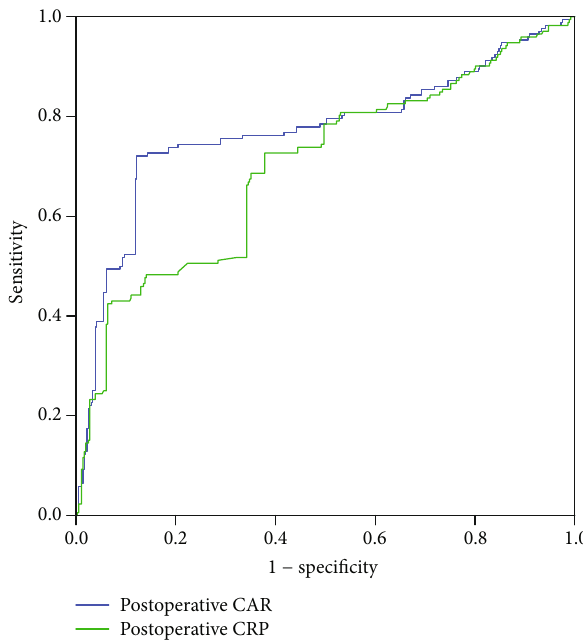
Table 3: ROC curve showing postoperative CAR levels on POD1 and CRP on POD3 levels predict postoperative complications.